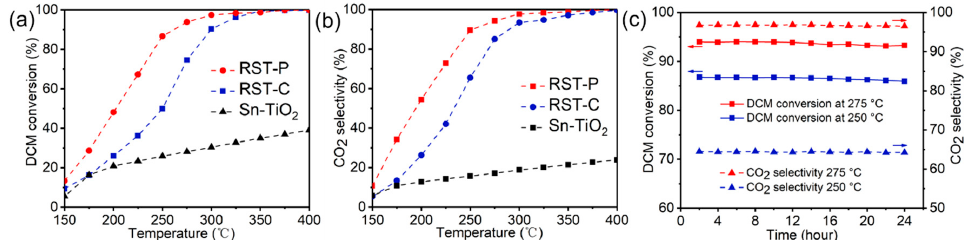
Figure 1. Catalytic performance of DCM oxidation by different synthesis methods: ( a ) DCM conversion, ( b ) selectivity of CO 2 , ( c ) stability test for RST-P at 250°C and 275°C.